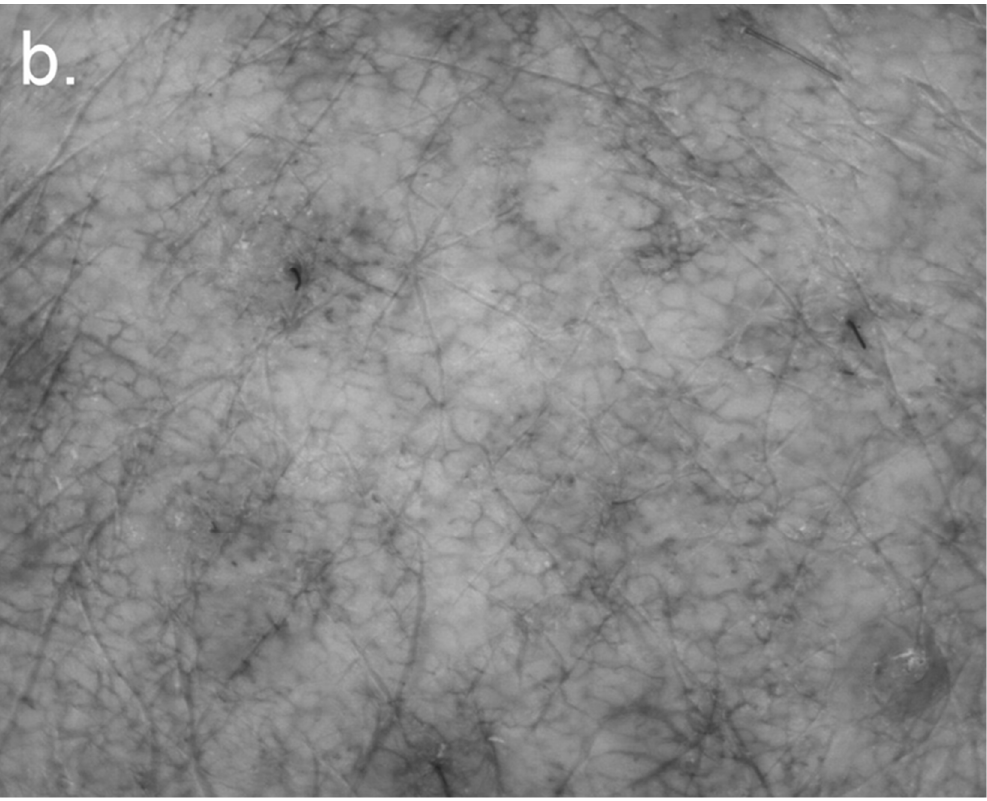
Figure 1. Example Visioscan ® VC 20plus images for ( a ) dry/xerotic skin and ( b ) normal/hydrated skin. Table 1. Summary of Visioscan ® VC 20plus measurement parameters